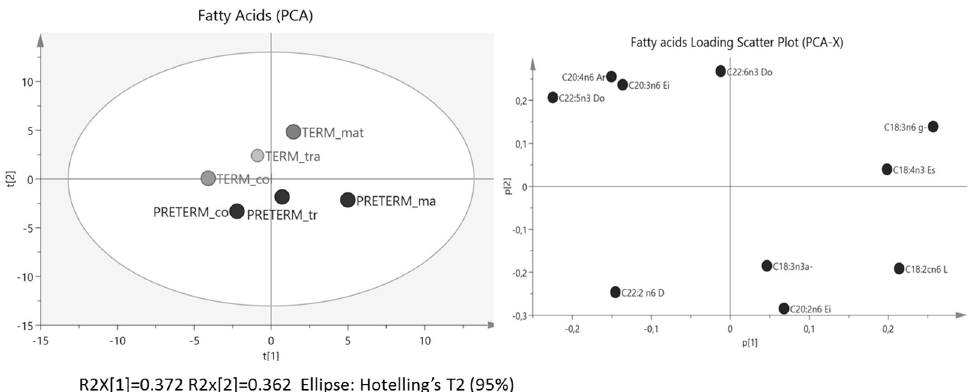
Figure 4. Principal Component Analysis (PCA) and Loading Scatter Plot of the fatty acid profile ( n = 40 fatty acids determined) obtained by gas liquid chromatography. By comparing the score and loading plot, the relationships between fatty acids and samples (term and preterm during lactation) could be identified.